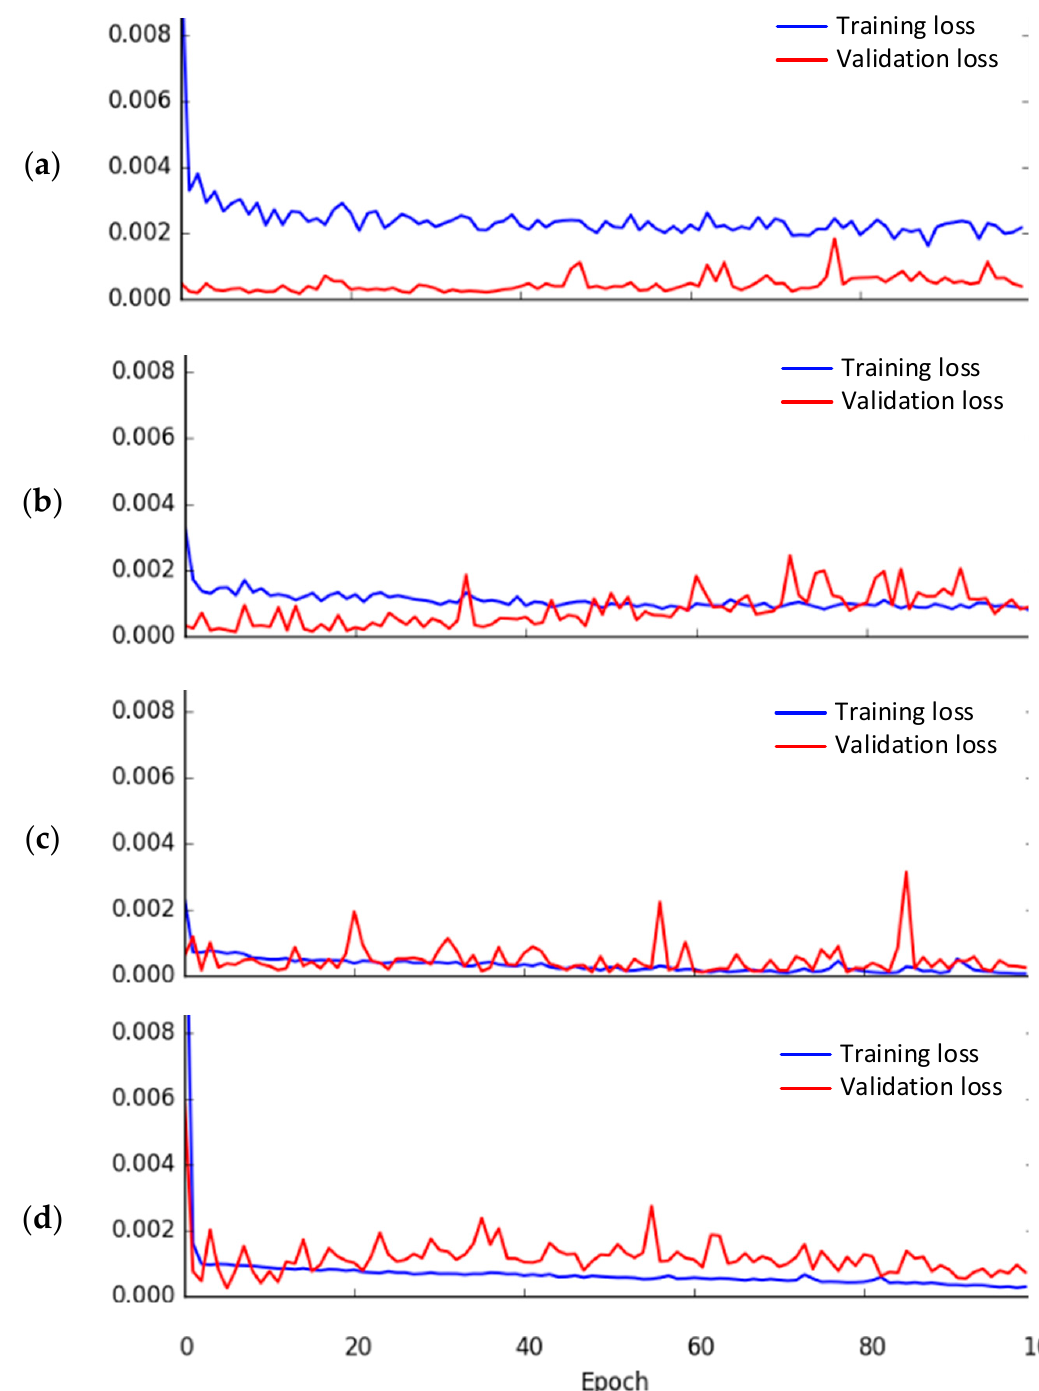
Figure 11. The model loss of RSRP after 6 s of prediction: ( a ) MLP, ( b ) CNN, ( c ) RNN, ( d ) LSTM.